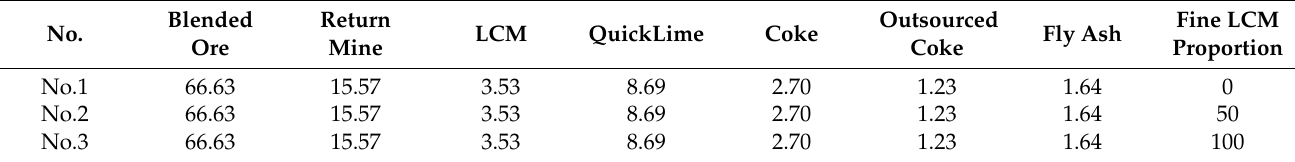
Figure 5. The test condition of low-temperature reduction. Table 4. Ore-Matching Scheme of the Sintering Pot Test (Mass,